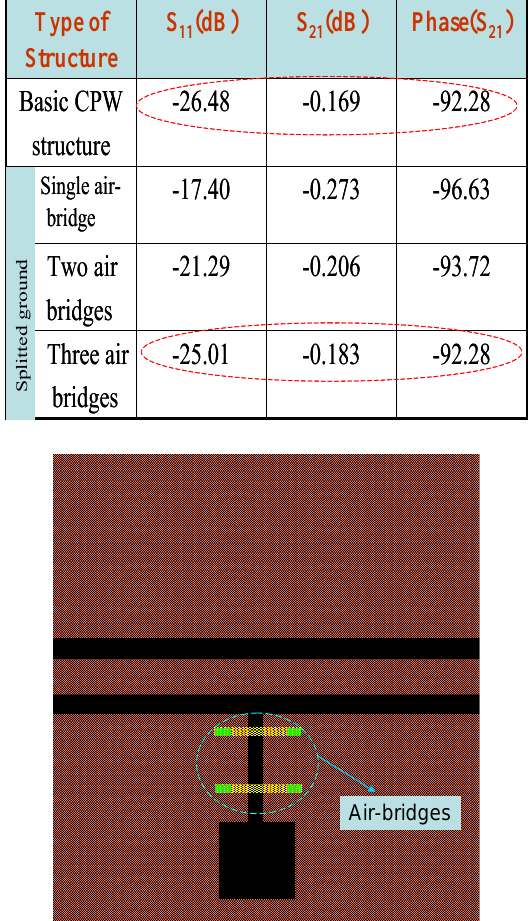
Figure 4: Reduction technique of no. of air